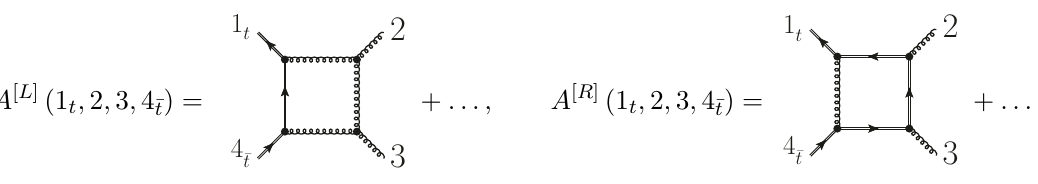
Figure 3 . Configurations for left- and right-moving primitive amplitudes contributing to gg